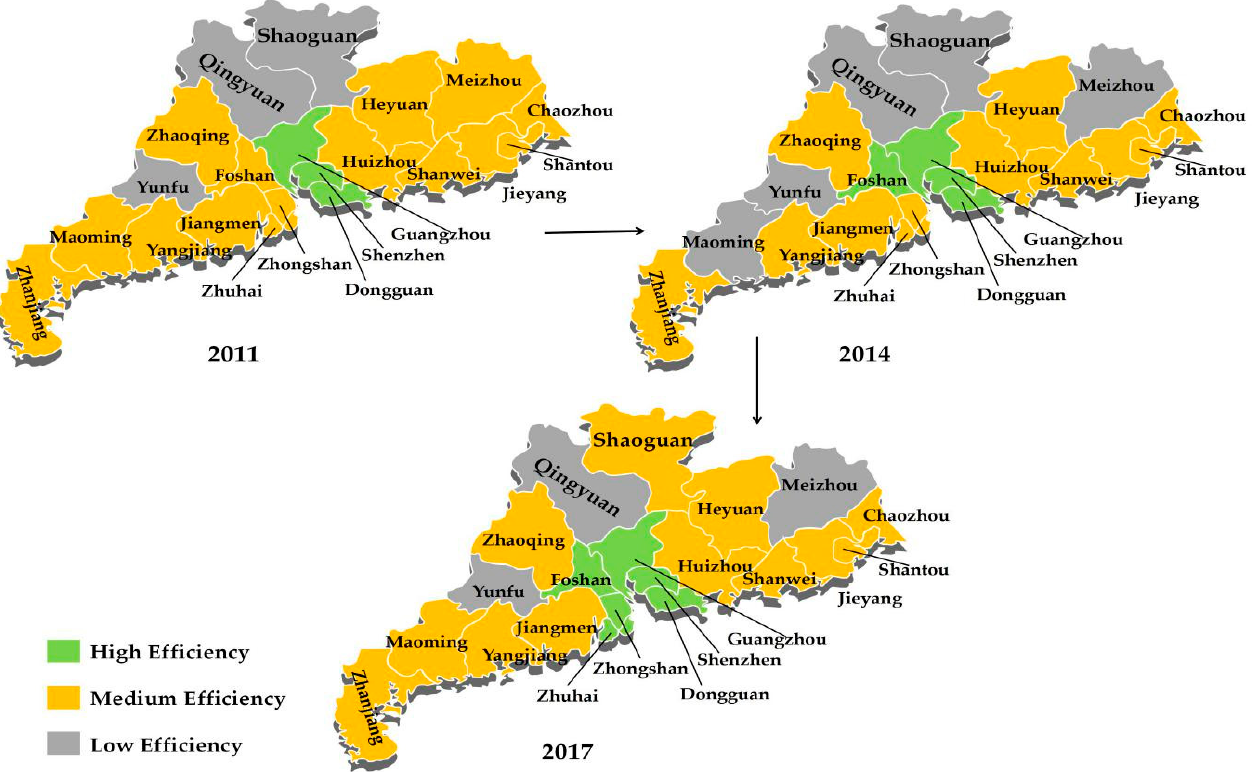
Figure 10. Spatio-temporal evolution map of land economic efficiency in Guangdong Province.